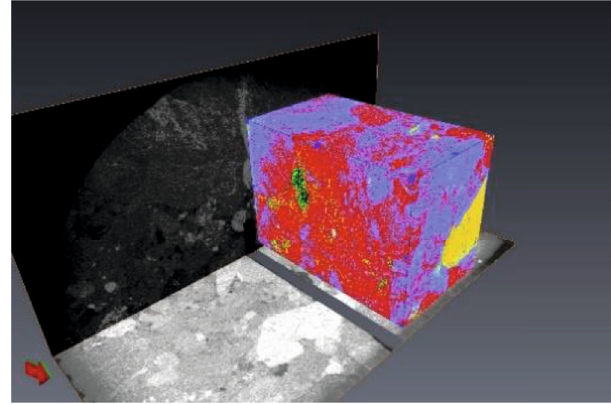
Figure 7: Spatial distribution of minerals in the subspace. The CT image of the entire core is preprocessed by selecting a speci fi c subspace.